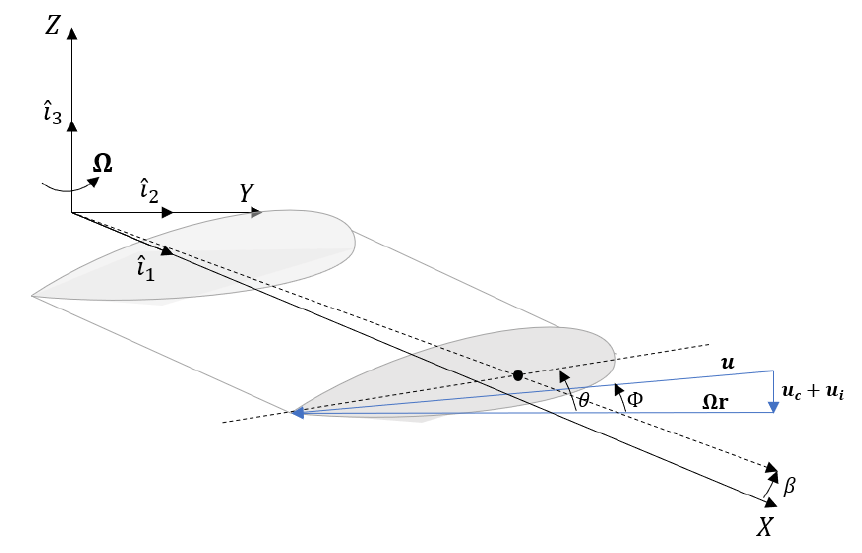
Figure 2. Velocity vector and angles definition for a blade station at distance r from the hub rotating